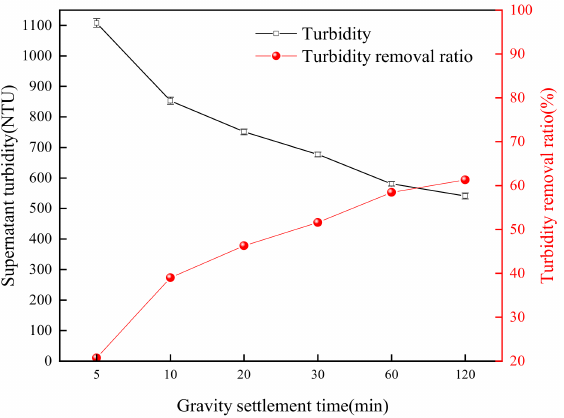
Figure 2. Gravity sedimentation effect of prepared flotation